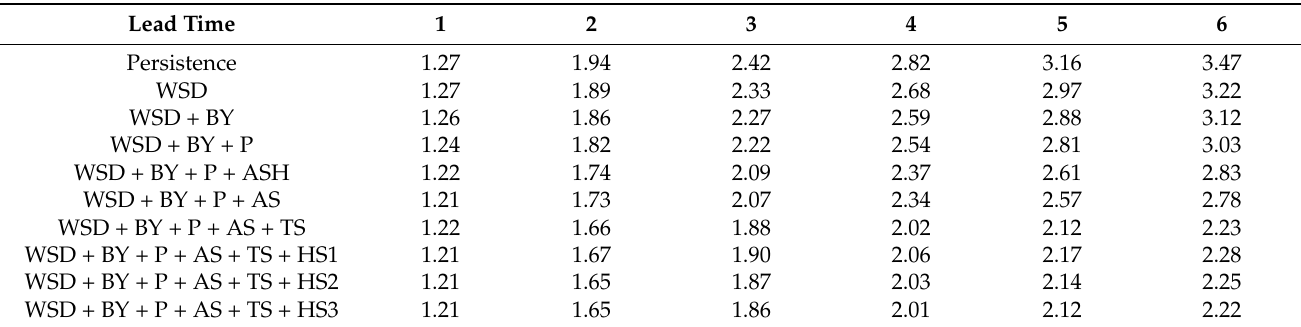
Figure 7. RMSEs of different models, which consist of different features. Table 3. The RMSEs of different models, which consist of different features.